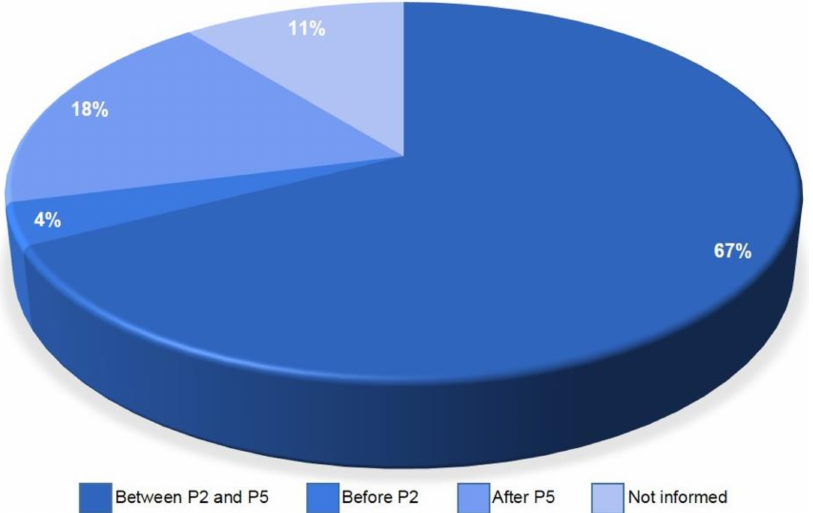
Figure 8. Number of cell culture passages for the experiments using AD-MSC, divided into 4 sections: not informed, after 5th passage (P5), before 2nd passage (P2) and between P2 and